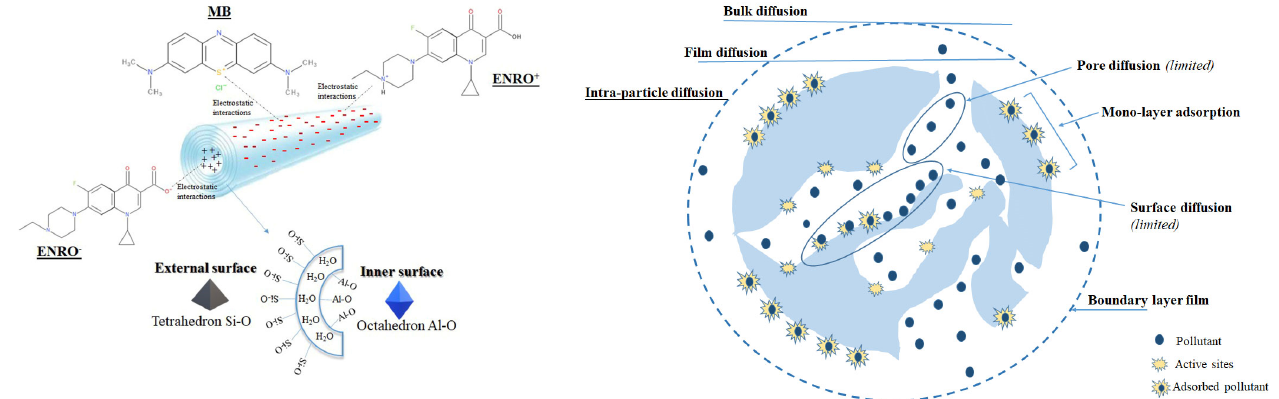
Figure 8. Possible adsorption mechanism of MB and ENRO onto HNC.